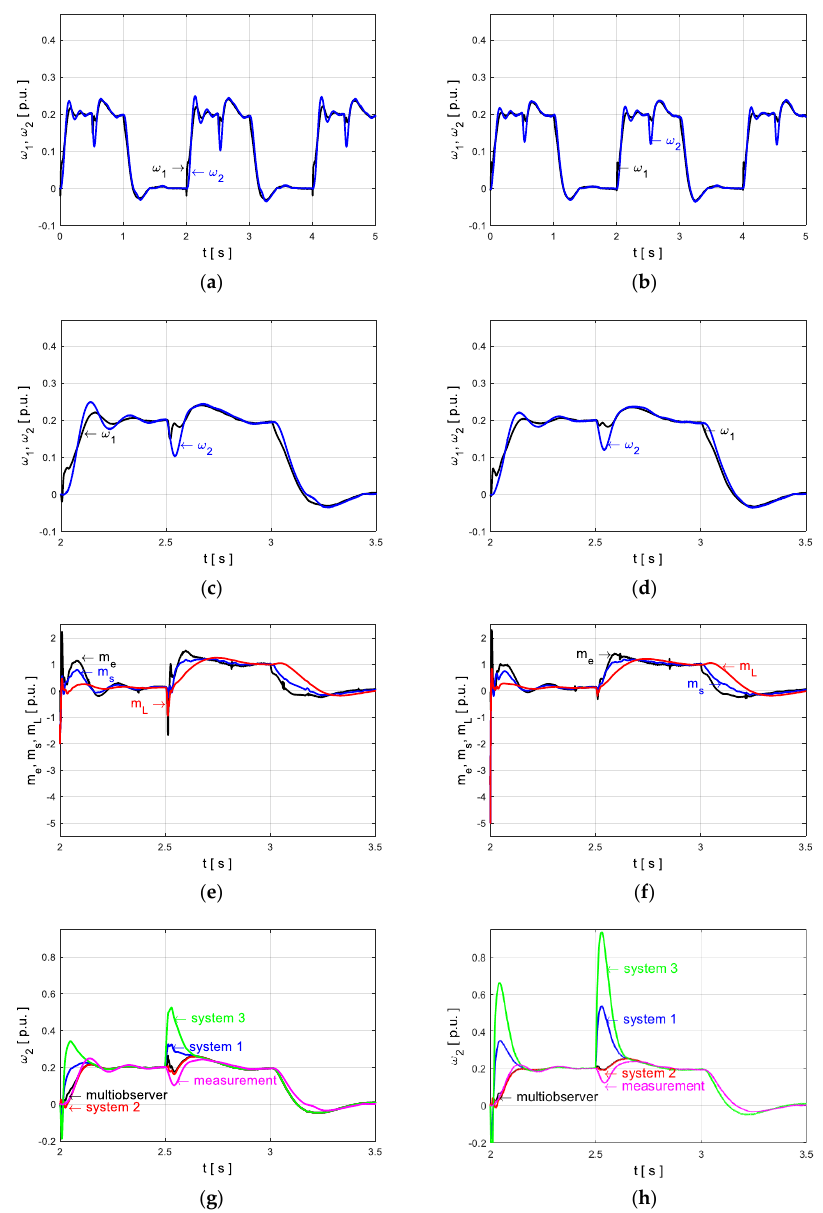
Figure 11. Transients of the system states: motor and load speeds ( a , b ) and it’s fragment ( c , d ), electromagnetic, estimated shaft and load torques ( e , f ), real and estimated load speed ( g , h ) for the system working in closed-loop structure with MLO – case 1 ( a , c , e , g ) and case 2 ( b , d , f , h ) – experiment. The tested system was working correctly. A small drop of the driving torque and motor speed can be observer at start-up resulting from non-correct values of estimated